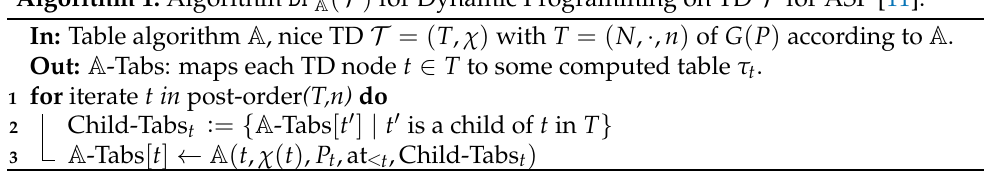
Algorithm 1: Algorithm DP A ( T ) for Dynamic Programming on TD T for ASP [11]. In: Table algorithm A , nice TD T = ( T , χ ) with T = ( N , · , n ) of G ( P ) according to A .